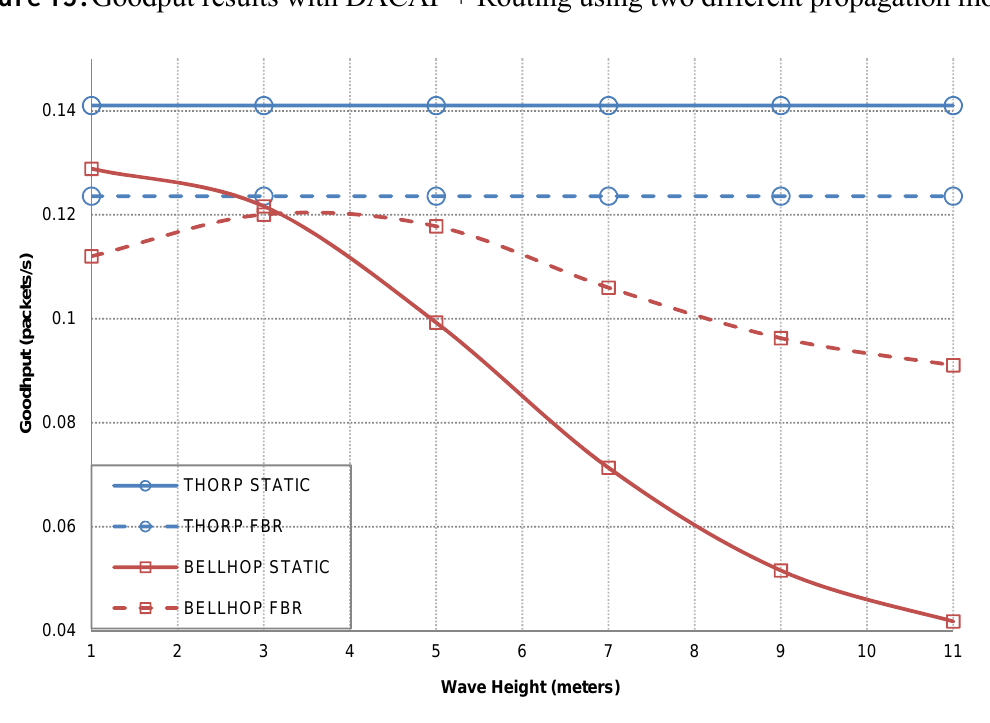
Figure 15. Goodput results with DACAP + Routing using two different propagation